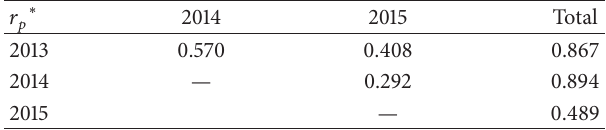
∗ The correlations are significant at the 0.01 level.